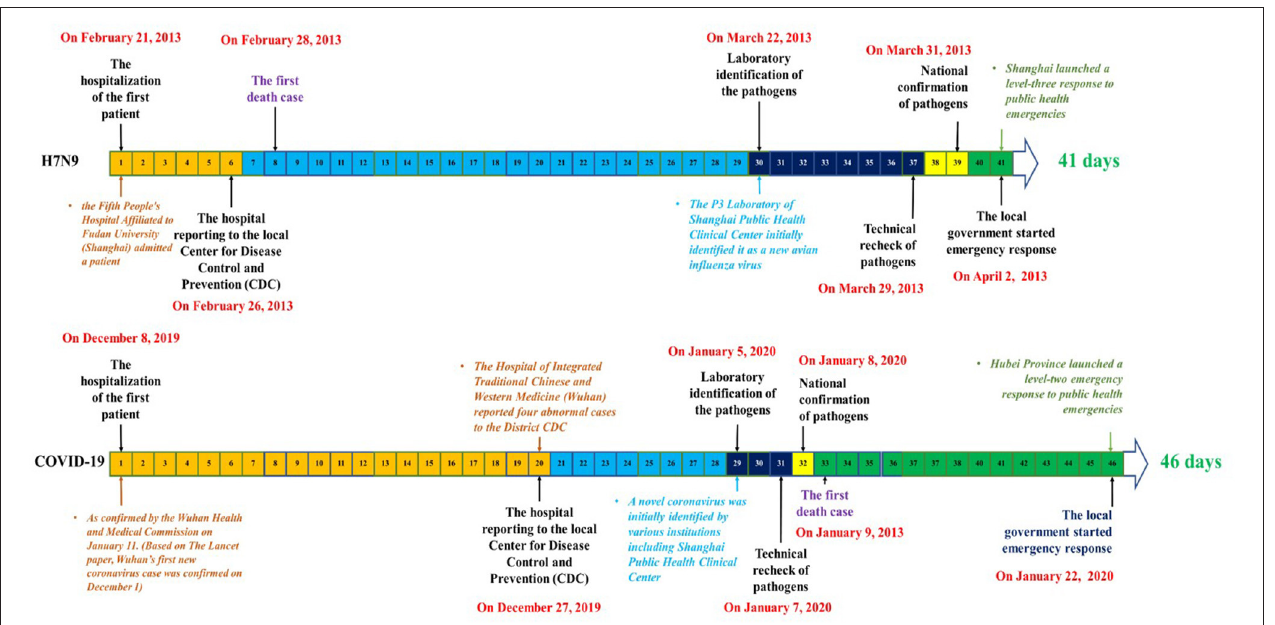
FIGURE 1 | Comparison of the emergency disposal timeline between H7N9 avian influenza (2013) in Shanghai and coronavirus disease 2019 in Wuhan.